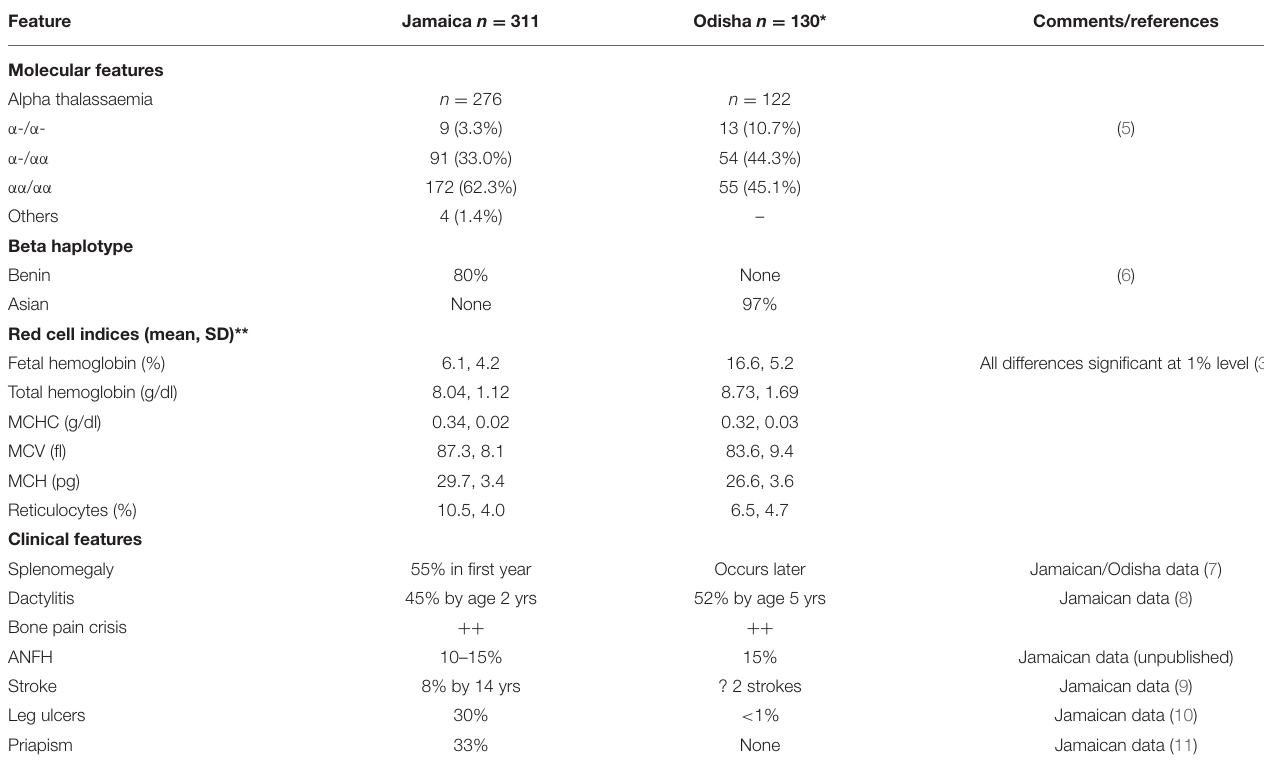
TABLE 1 | Features of patients with HbSS from Jamaica and western Odisha.